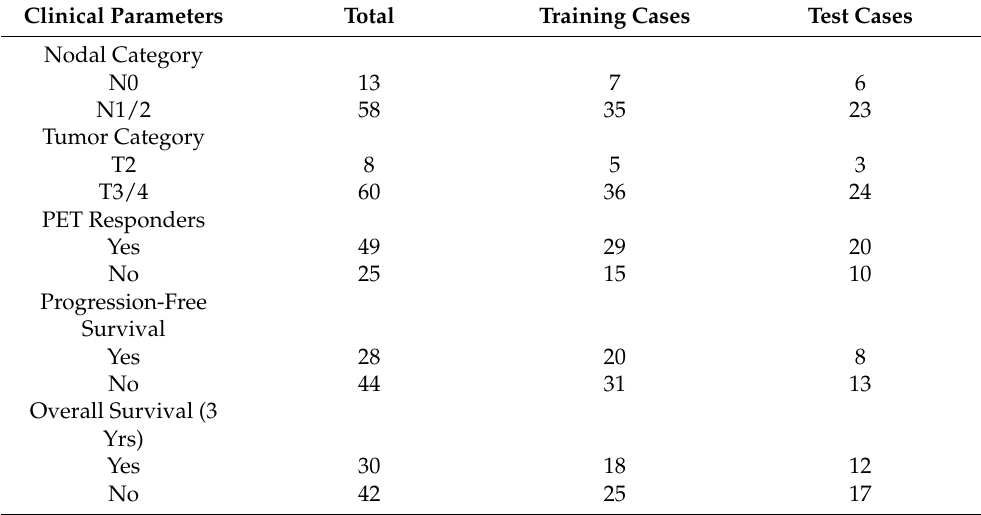
Table 3. Classifications of training and test datasets for different clinical parameters.